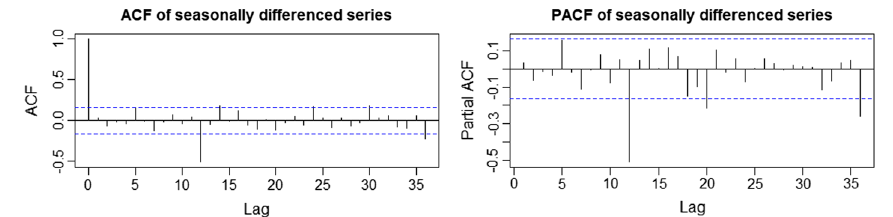
Fig. 2 Plot of autocorrelation and partial autocorrelation of seasonally differenced gold futures price series